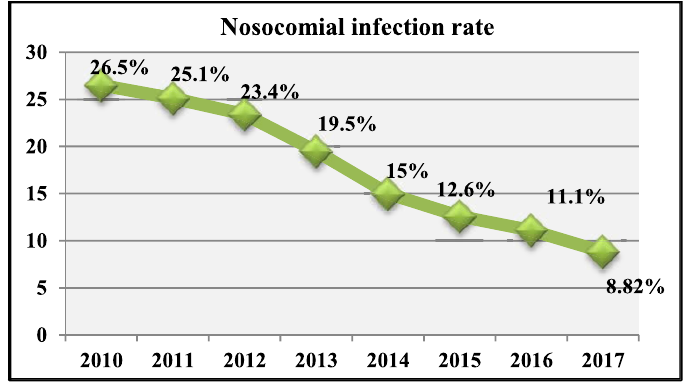
Fig. 1. Nosocomial infection rate from 2010-2017